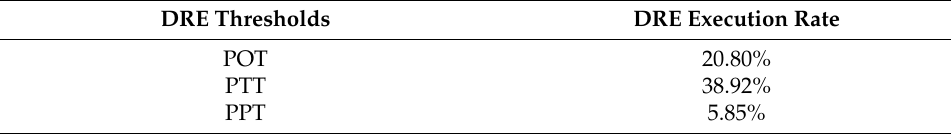
Table 2. Dynamic risk evaluation execution rates under normal operation.